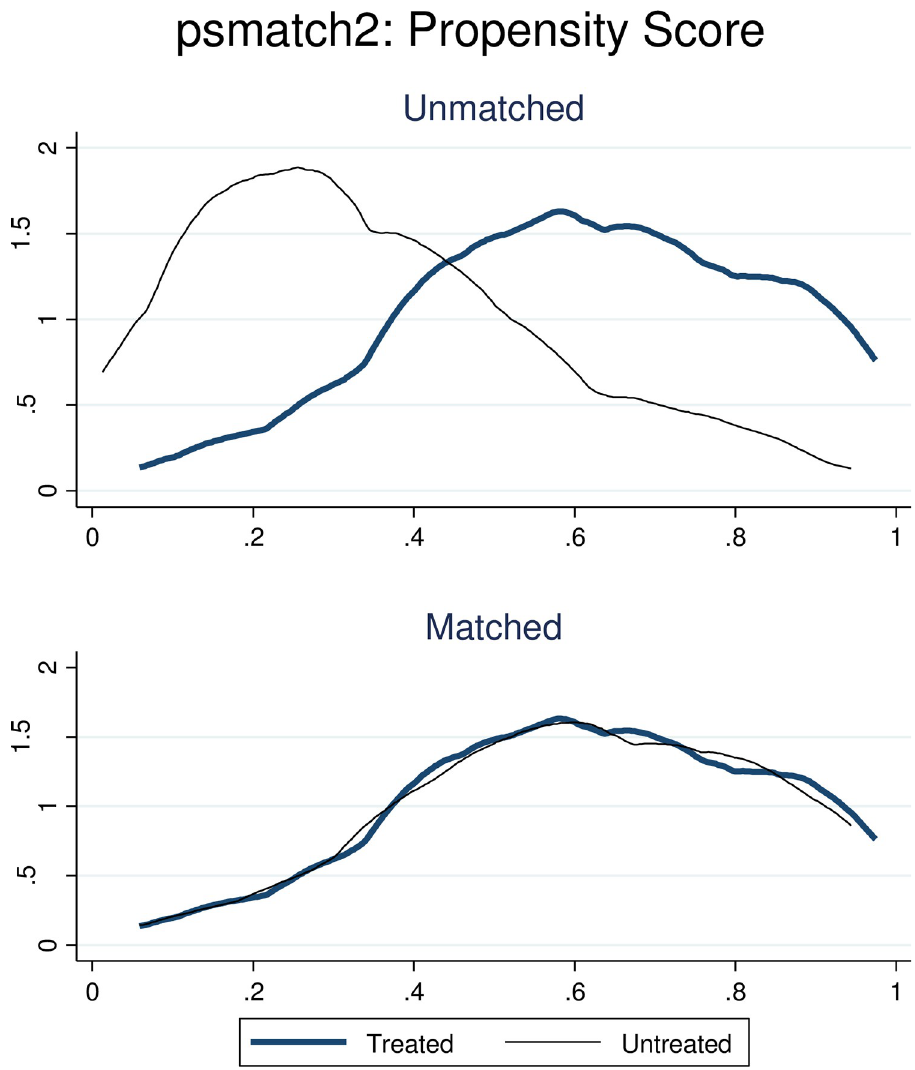
Fig 1. The comparison of the density estimation of both insured and uninsured groups before and after matching in Kutaber district, Ethiopia, 2020. The common support area is those propensity scores within the range of the lowest and highest estimated values for households in the treatment groups. Before the propensity score matching, the insured and uninsured groups were dissimilar with regard to the characteristics measured by the propensity score, and after matching, they were